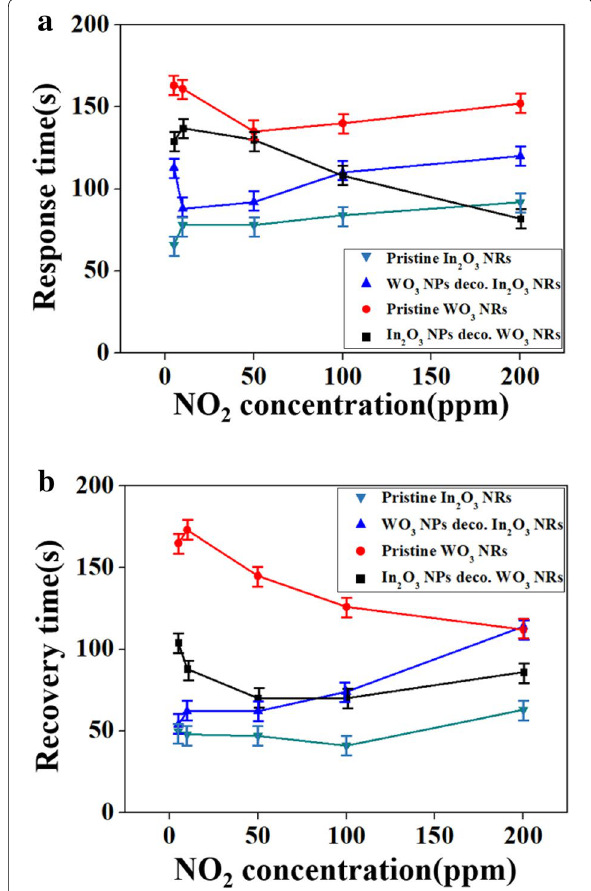
Fig. 7 Calibration curves for a response times and b recovery times of pristine and In 2 O 3 NPs‑decorated WO 3 NRs as well as pristine and WO 3 NPs‑decorated In 2 O 3 NRs to NO 2 as a function of NO 2 concentrations